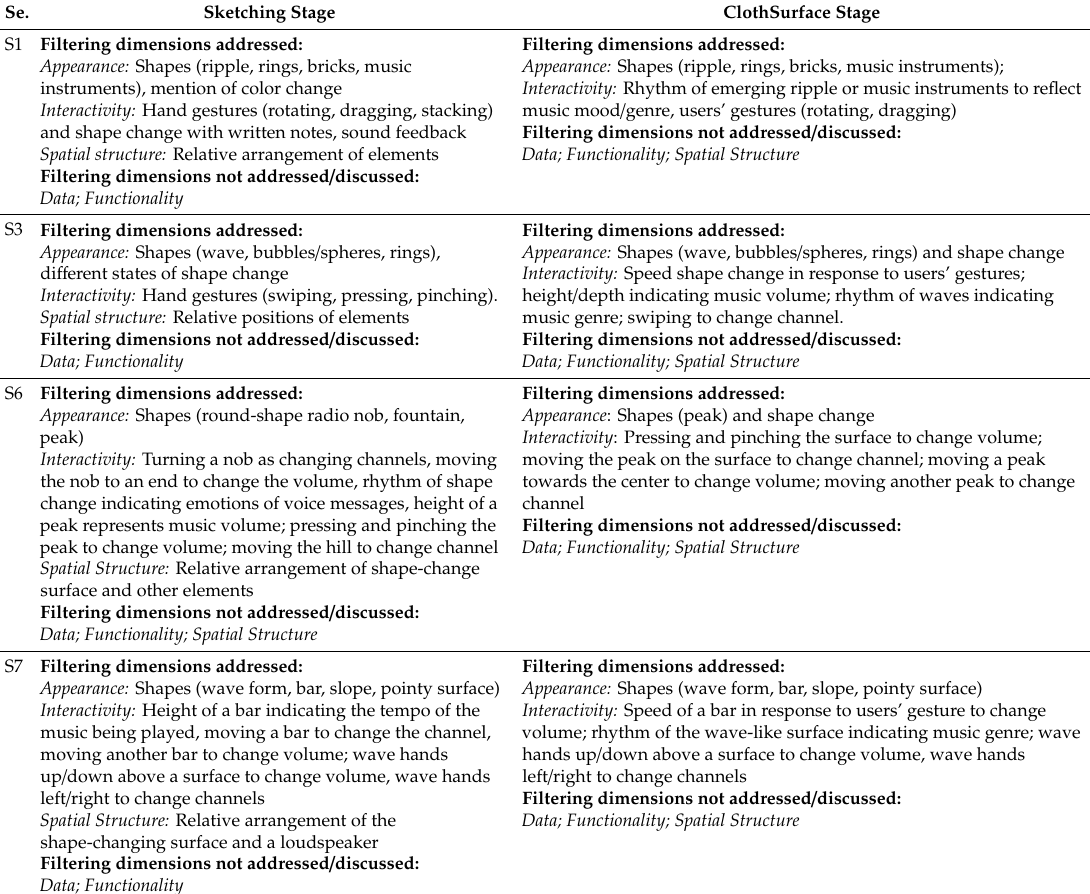
Table A2. Filtering Dimensions in the Sessions Assigned to the Radio Design Tasks (1A &